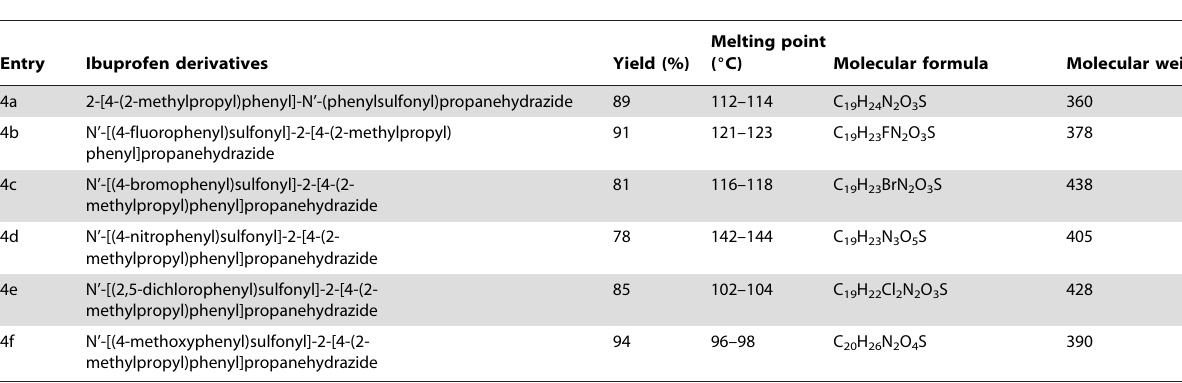
Table 1 . Physical and chemical characteristics of new Ibuprofen